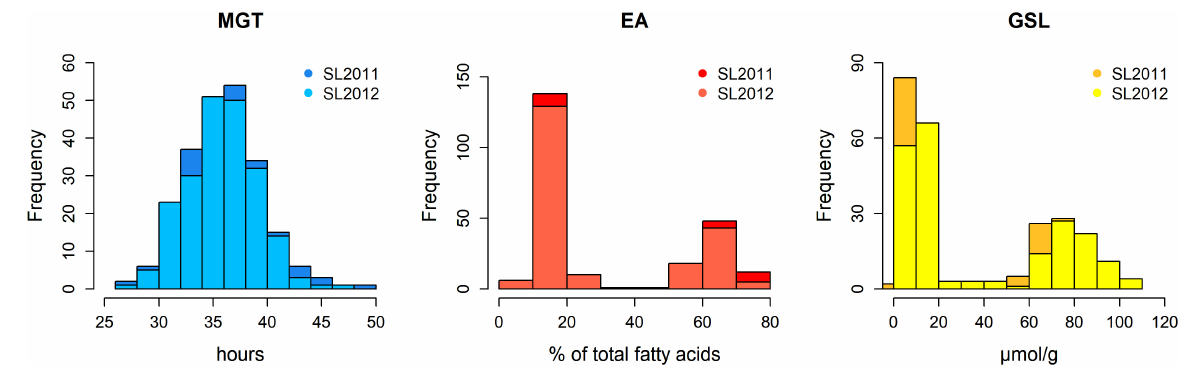
Frontiers in Plant Science |